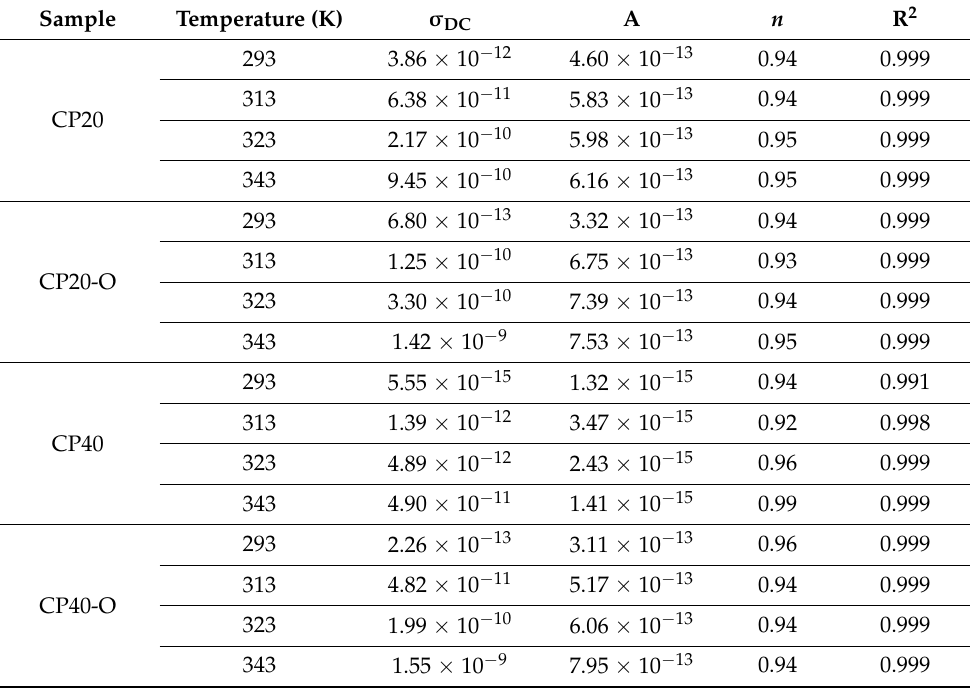
Figure 12. DC conductivity ( σ DC ) for the neat (CP0), modified unoriented (CP20, CP40), and oriented (CP20-O, CP40-O) copolymers. Table 6. Jonscher’s parameters for the modified oriented and unoriented copolymers.